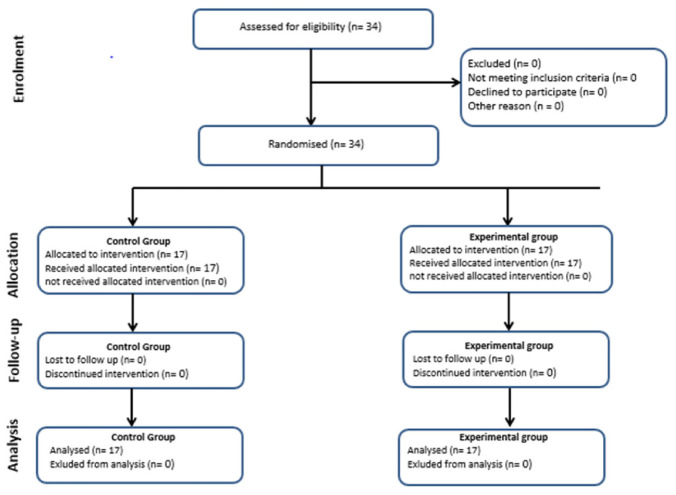
The diagram (The CONSORT: Consolidated Standards of Reporting Trials) includes detailed information on the interventions received.